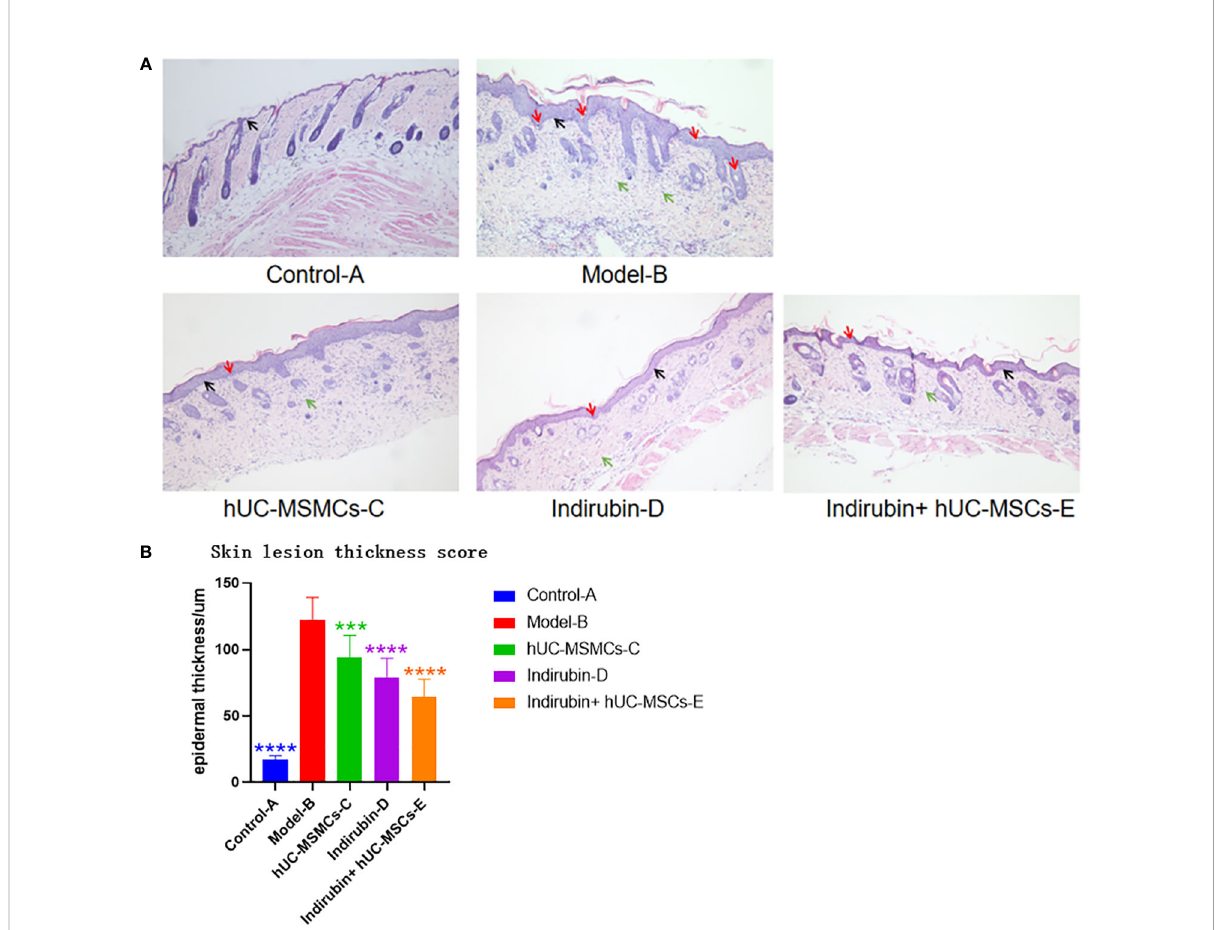
FIGURE 5 Thickness of epidermal layer was measured by H & E staining images of mice in each group. (A) HE staining results of pathological changes of skin tissues of mice in each group (200×). (B) Thickness of epidermal layer of mice in each group (one-way ANOVA/Dunnett ’ s test). ****P < 0.0001, ***P < 0.001, compared with model (B) Red arrow: Munro microabscess; Black arrow: spinous cells; Green arrow: in fl ammatory cells.